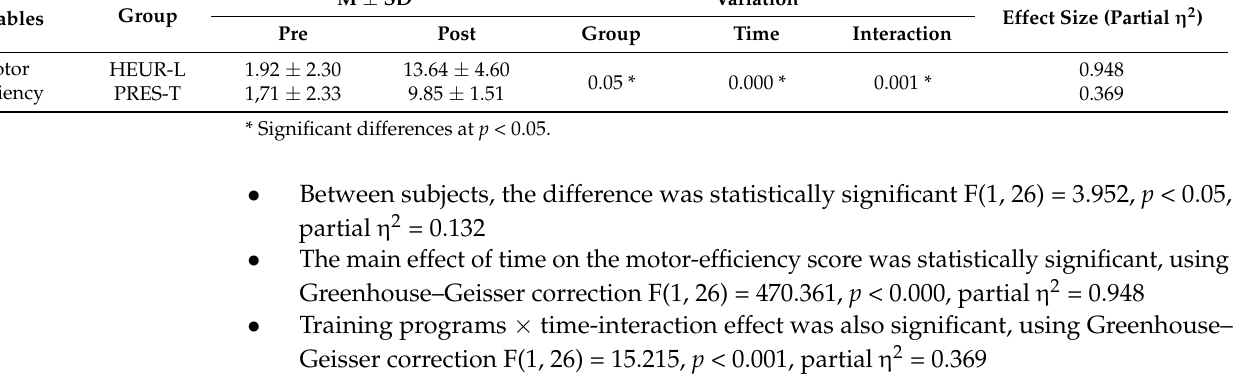
Table 2. Summary of two-way ANOVA results for the differences in motor efficiency according to group (HEUR-L and PRES-T), time (pre–post), and interaction groups × time. Variables